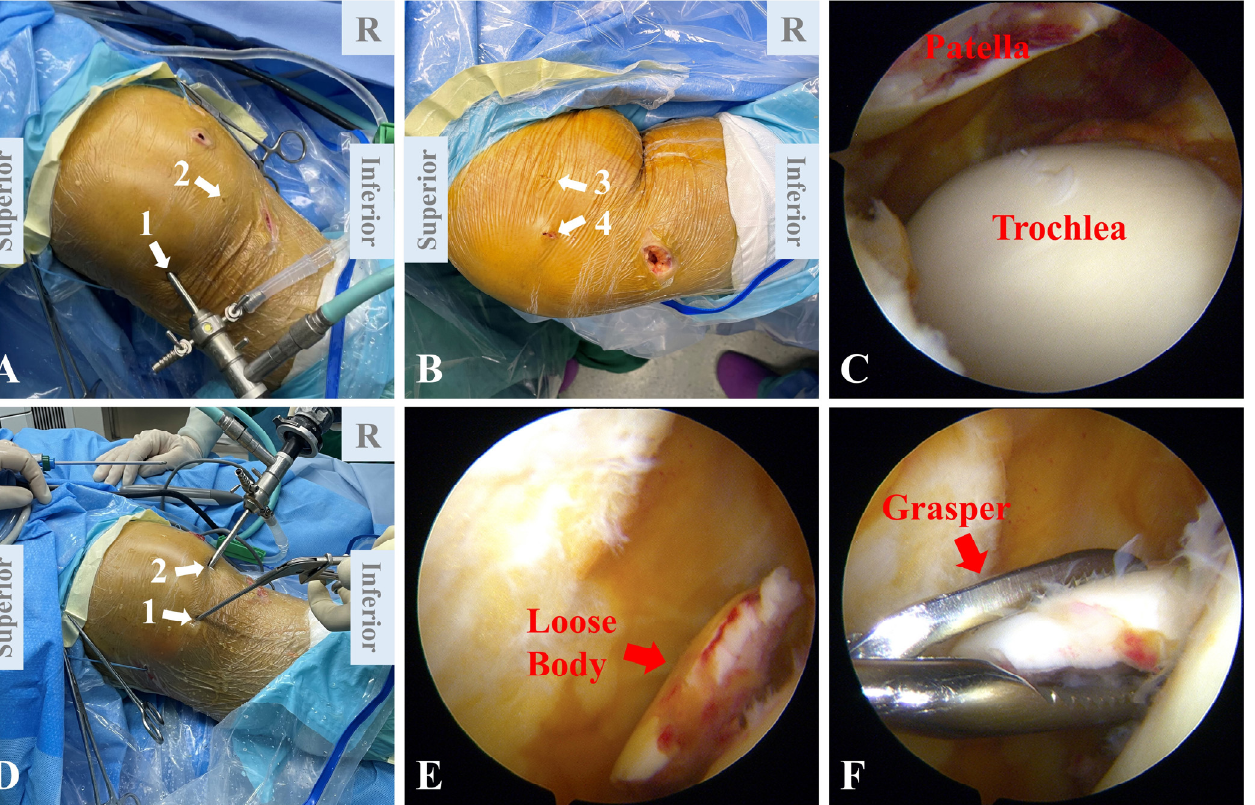
Figure 3. Arthroscopic portal placement and diagnostic arthroscopy. ( A ) An anterolateral portal (arrow 1) is made 1 cm lateral to the patellar tendon near the inferior pole of the patella. An anteromedial portal (arrow 2) is established 1 cm medial to the patellar tendon near the inferior pole. ( B ) Auxiliary medial portal 1 (AMP1, arrow 3) is made between the adductor tubercle and the medial epicondyle for the establishment of the femoral tunnel. Between the upper-third point of the medial patella and the AMP1, auxiliary medial portal 2 (AMP2, arrow 4) is created for the establishment of the patellar tunnel. ( C ) Diagnostic arthroscopy showing a flat trochlear groove and the patella lying laterally to the trochlea. ( D ) Removal of loose body is performed. The arthroscope is placed through the anteromedial portal (arrow 2), and a grasper is placed through the anterolateral portal (arrow 1). ( E ) Arthroscopic view of the loose body. ( F ) Arthroscopic view of the grasper removing the loose body.